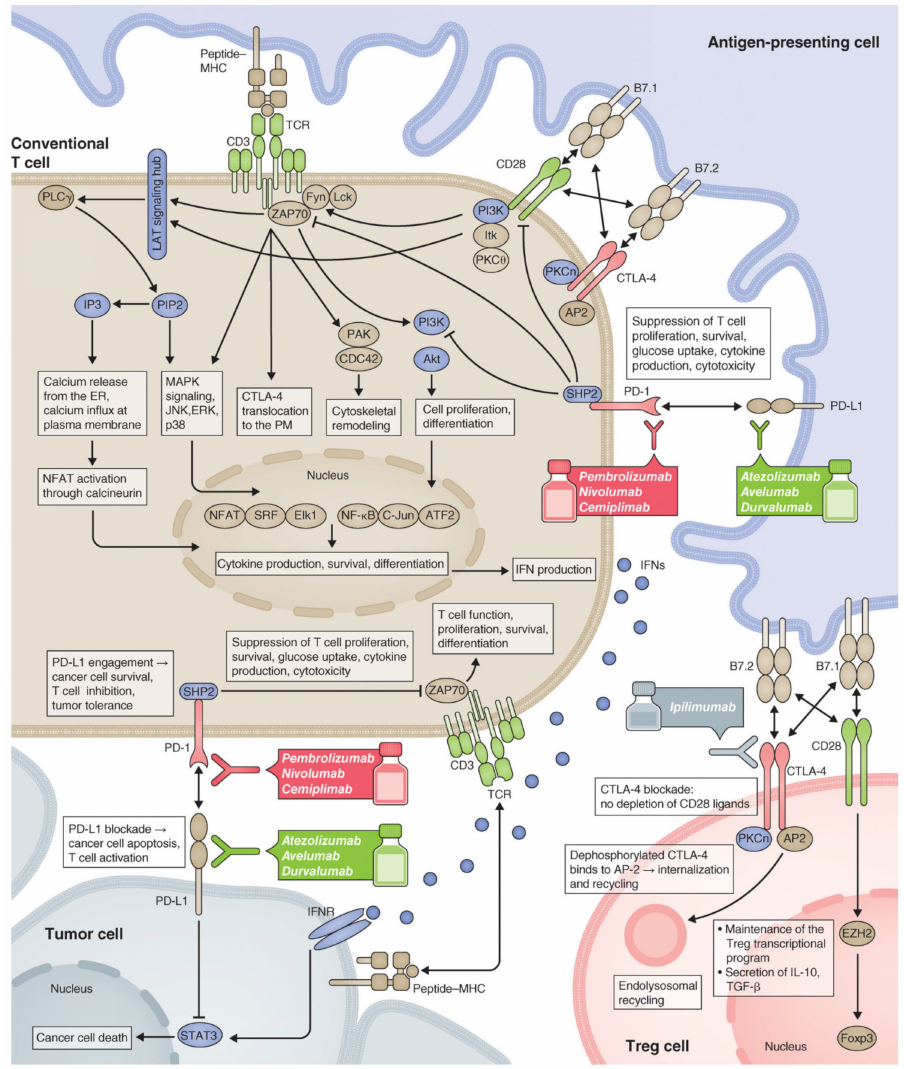
Figure 5. Mechanism action of Immune Checkpoint Inhibitors (ICIs). Reproduced with permission from the Journal of Cell Biology